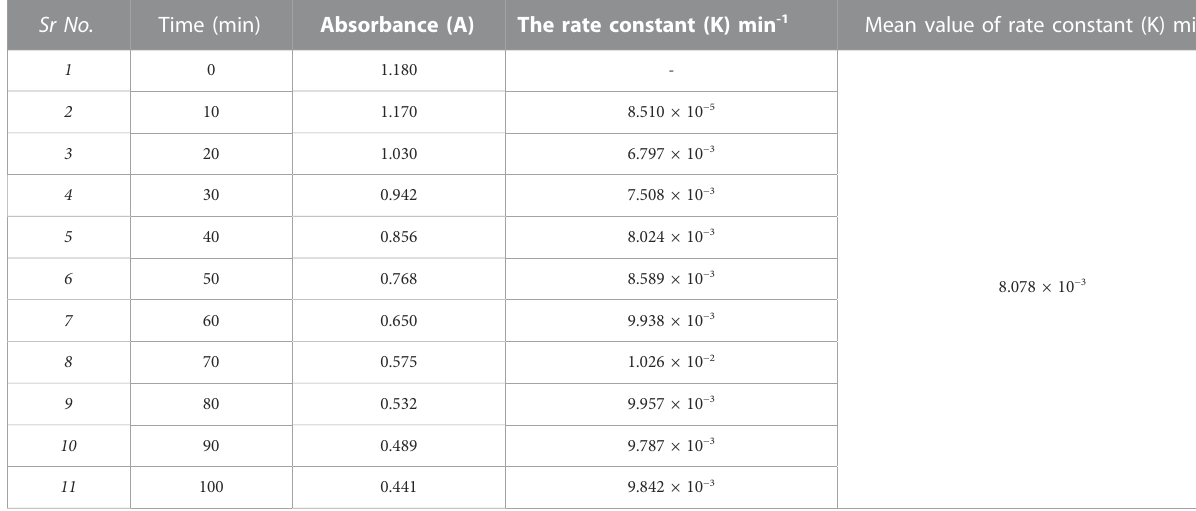
TABLE 2 Dye solution absorbance with time (min).